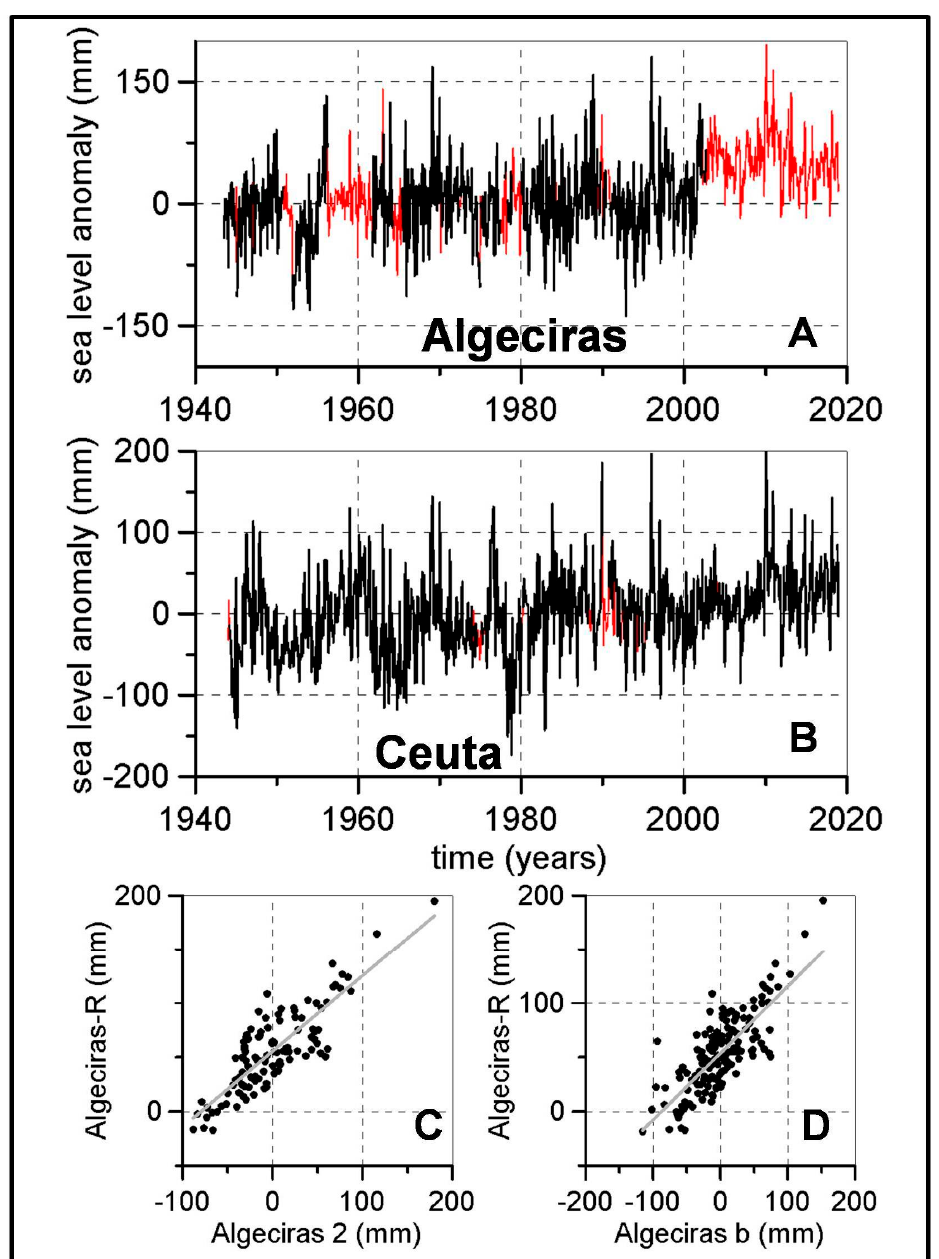
Figure 4. Observed and reconstructed sea level anomalies for Algeciras and Ceuta. Black lines in ( A , B ) are the time series of anomalies (observed minus seasonal cycle) at Algeciras and Ceuta. Red lines are the time series of anomalies of sea level where gaps have been filled using nearby stations. ( C , D ) show the regression of the reconstructed time series on two redundant sea level time series at Algeciras.